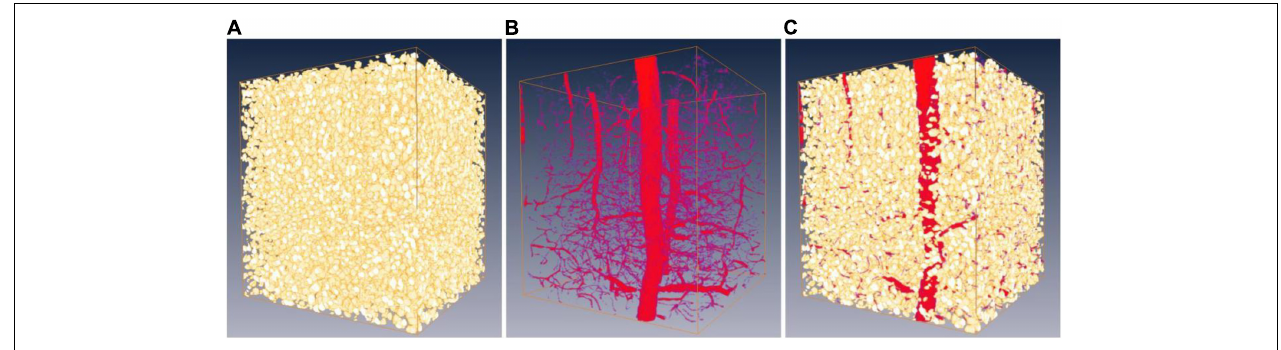
FIGURE 8 | Predictions on a 3D MOST image stack by the boosted network. Panels (A,B) are the predictions of somata (shown as gold standard) and vessels (shown as red). (C) 3D reconstruction of somata and vessels by merging (A,B)